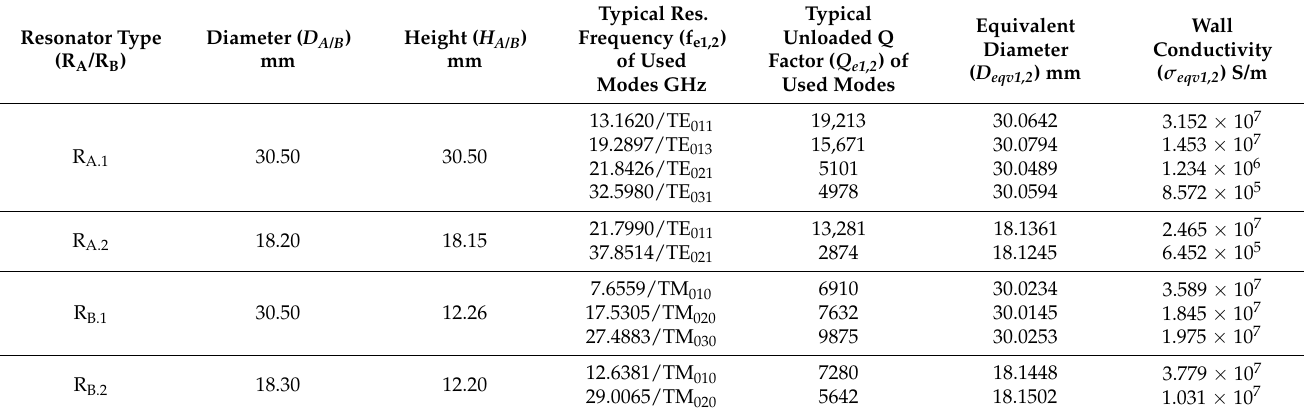
Table 1. Measured parameters for the empty